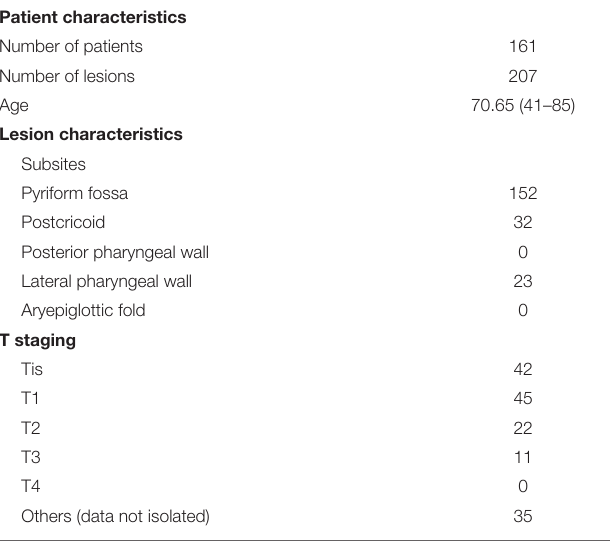
TABLE 4 | Patient and lesion characteristics of